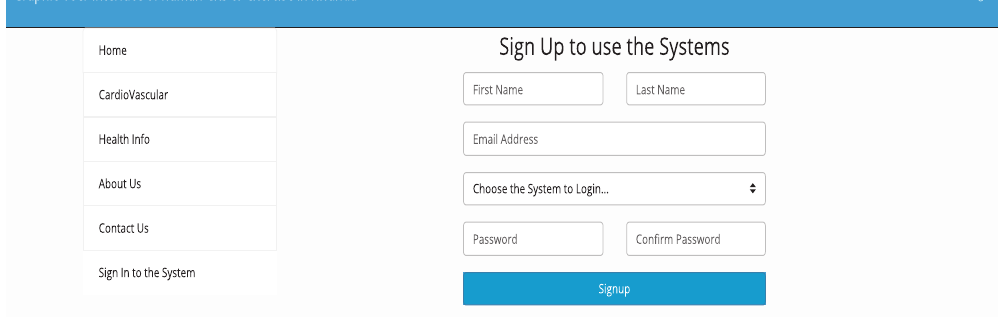
Figure 4: Screen layout to login